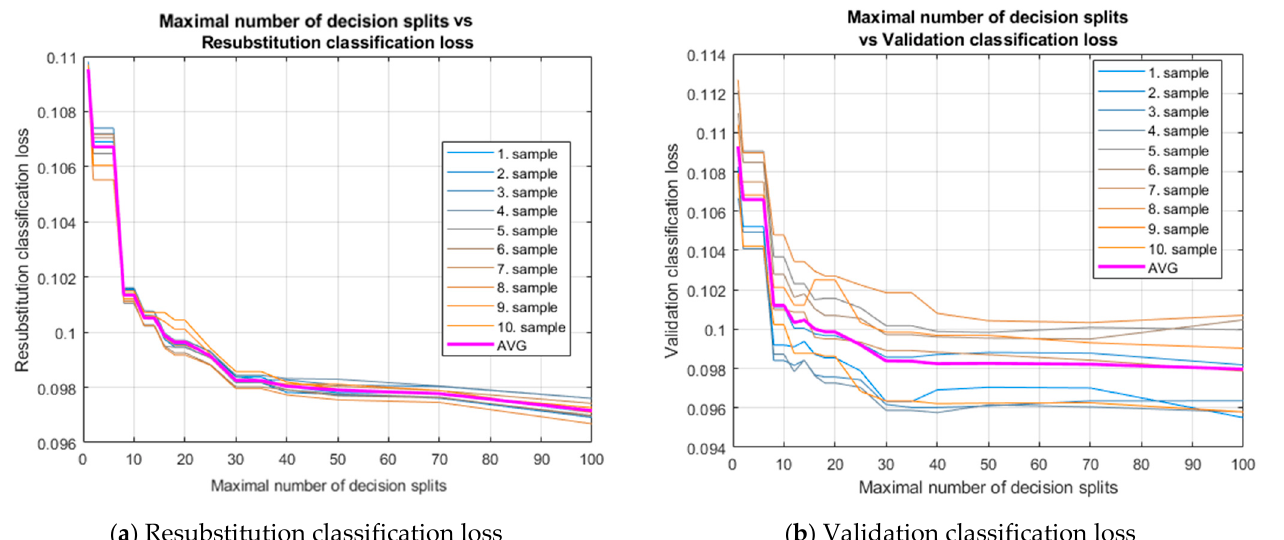
Figure 3. Summary of iteration of the maximal number of decision splits versus the classification losses in the CART element.